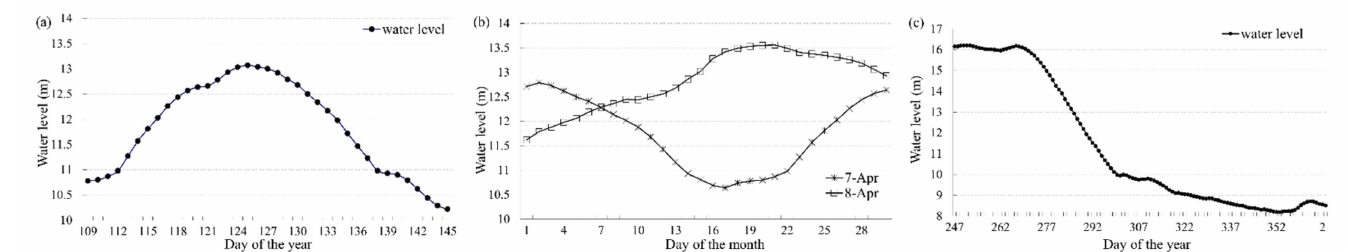
Figure 7. Temporal profile of water level data: ( a ) water level from 19 April to 25 May 2007; ( b ) comparison of water level in April 2007 and 2008; ( c ) water level from 4 September 2007 to 3 January